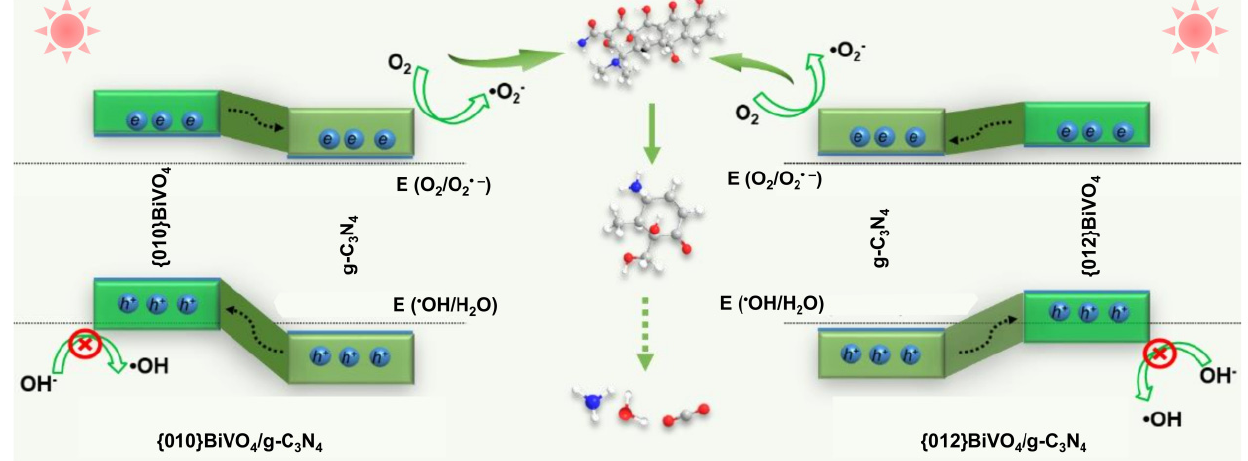
Figure 8. Photocatalytic mechanism speculations over {010}BiVO 4 /g-C 3 N 4 and {012}BiVO 4 /g-C 3 N 4 .